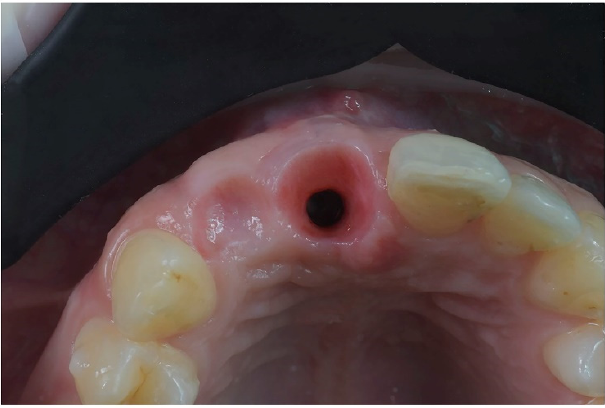
Figure 13. Case 2. Dynamic compression of the soft tissues.